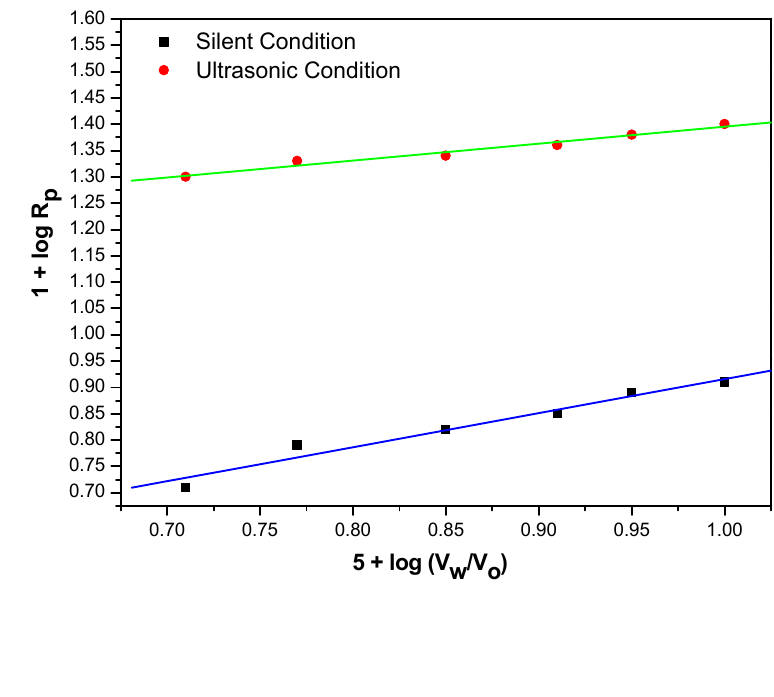
Figure 11. Bi-logarithmic plot illustrating influence of volume fraction of aqueous phase on the R for the polymerization of MABE under US-MPTC and Silent-MPTC conditions: p 2.00 × 10 − 2 mol·dm − 3 of PPS, 1.2 × 10 − 2 mol·dm − 3 of BPMACB, 3.0 mol·dm − 3 of MABE, 0.3 mol·dm − 3 of [H + ], 0.1 mol·dm − 3 of [µ], 60 °C of temperature (50 kHz, 300 W for ultrasonic assisted